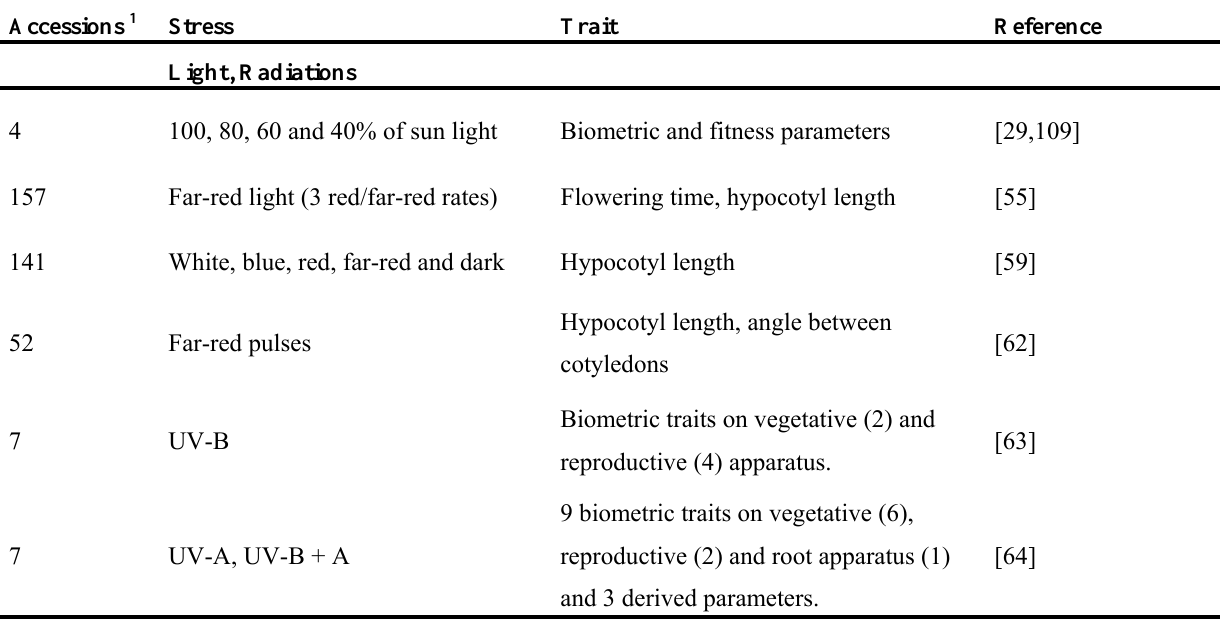
Table 1. List of studies reporting characterization of Arabidopsis accessions in response to abiotic